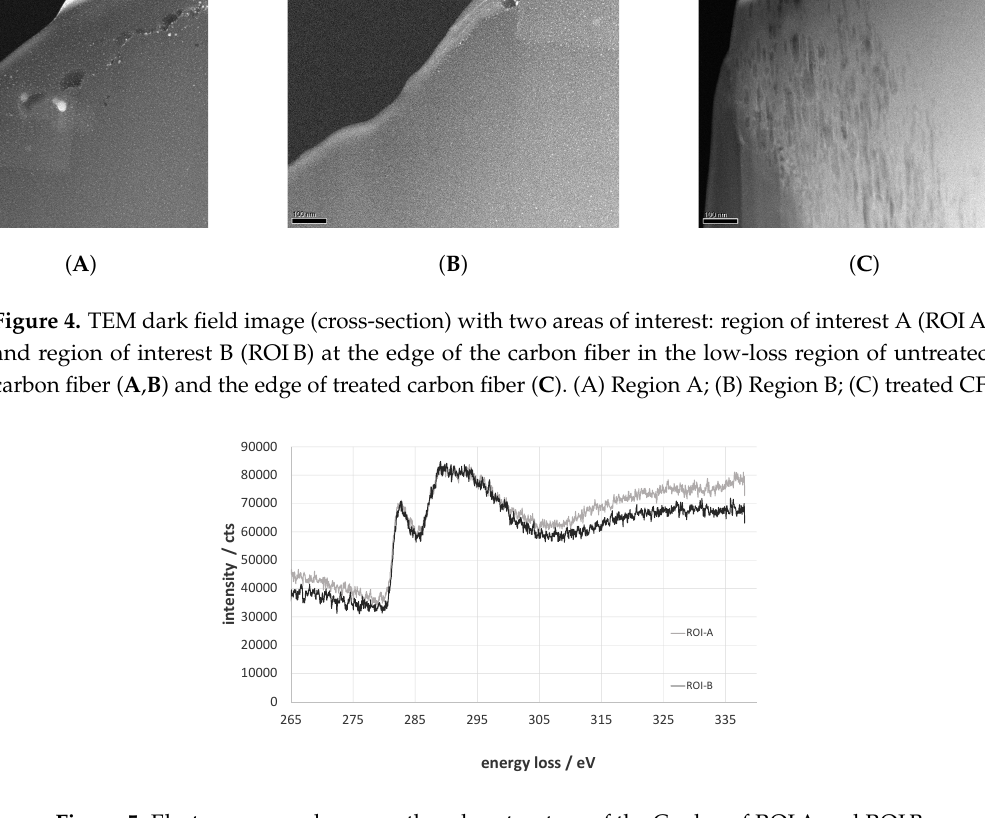
Figure 5. Electron energy-loss near the edge structure of the C-edge of ROIA and